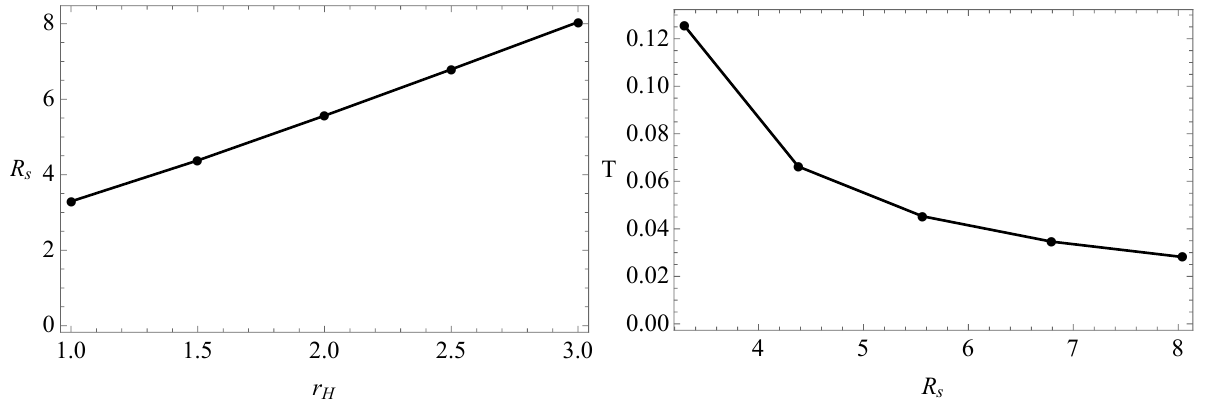
Figure 5. Left panel : The typical shadow radius of the spinning quantum deformed BH viewed in θ o = π /2 as a function of the event horizon radius. Right panel : The Hawking temperature of the spinning quantum deformed BH as a function of typical shadow radius. We have set a / M = 0.65 and b / M =